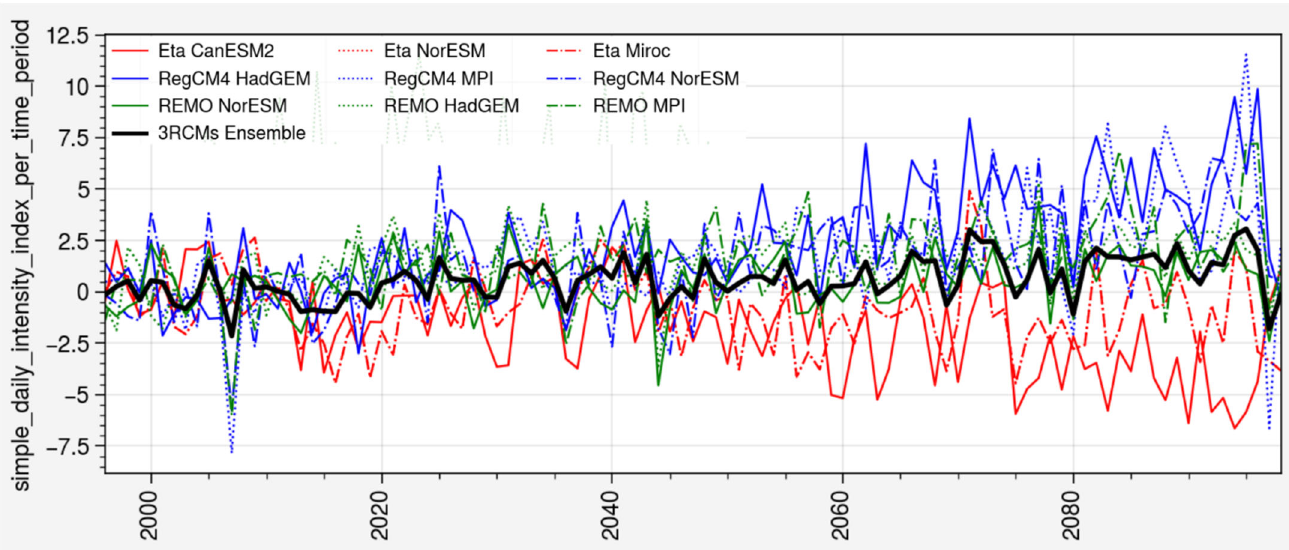
Figure 10. SDII trend time series (1995–2099) of all RCMs members and the 3RCMs ensemble (continuous black line), considering the historical average of 1995–2014 during austral summer in the LPB.